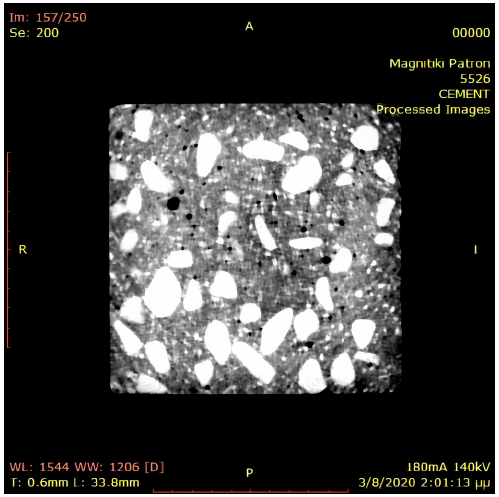
Figure 2. A 2D computed tomography (CT) image of